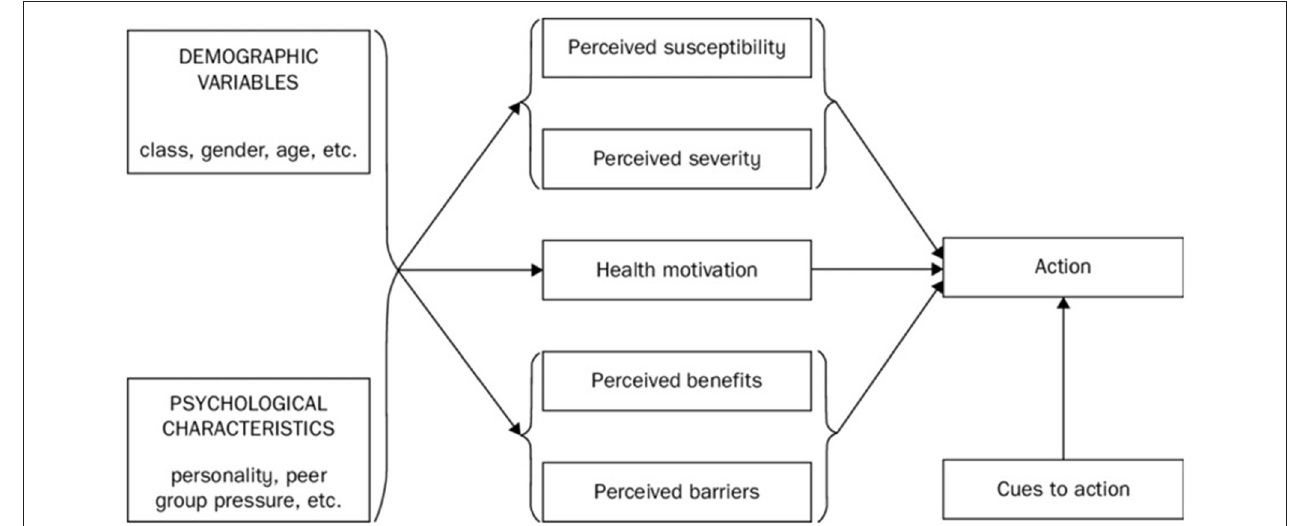
FIGURE 1 | Reasons for vaccine